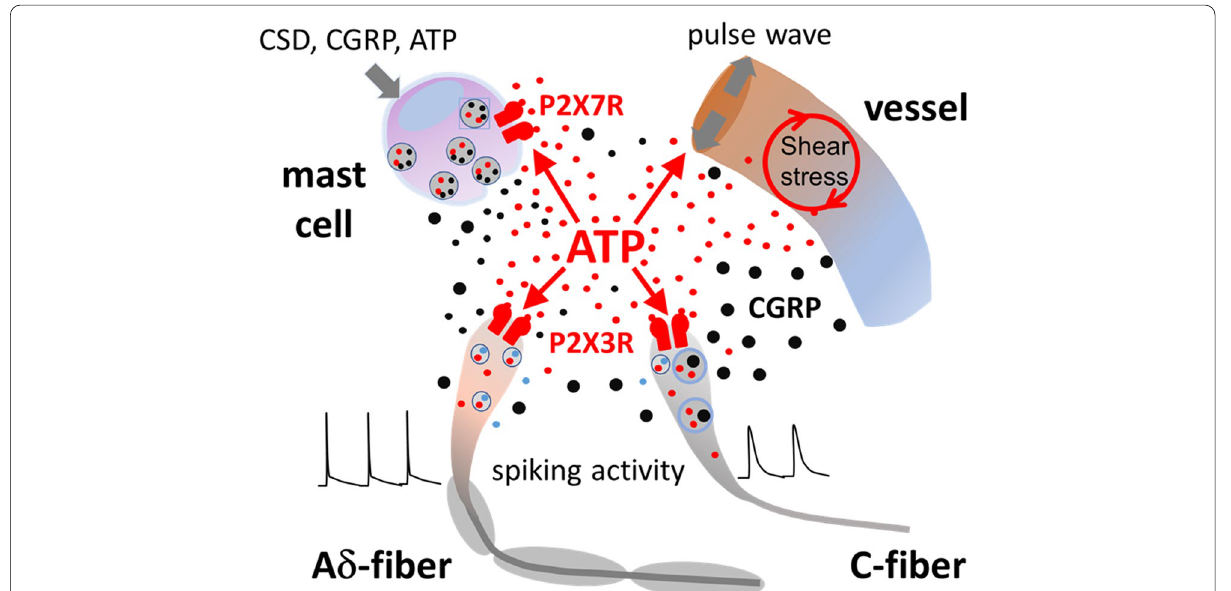
Fig. 2 Proposed ATP-mediated pro-nociceptive signalling in the meninges involving trigeminal neurons, immune cells and local vessels. Meninges are densely innervated, colonized by local immune cells and largely vascularized. Extracellular ATP (small red circles) can: i ) activate ionotropic P2X3 receptors in C- and Aδ-fibers [26, 86]; ii ) degranulate mast cells via P2X7 receptors [27, 84]; iii ) modulate vascular tone via metabotropic P2Y13 and P2X1 receptors [47, 73]. Other non-purinergic transmitters in this system, for sake of simplicity, are indicated only schematically as small black circles (for instance serotonin from mast cells) or small blue circles (glutamate from